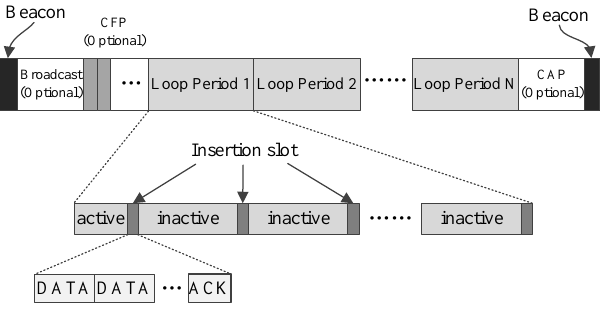
Figure 3. The superframe structure of LDC-MAC for supporting a WBAN in which low data-rate nodes and high data-rate nodes